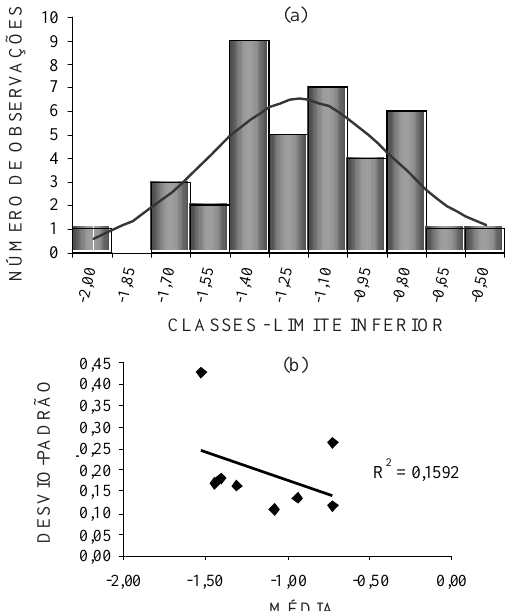
Figura 2. Distribuição de freqüências (a) e desvio- padrão de acordo com a média (b) para subamostras de 5 observações para o logaritmo da taxa de infiltração após 3,5 min.